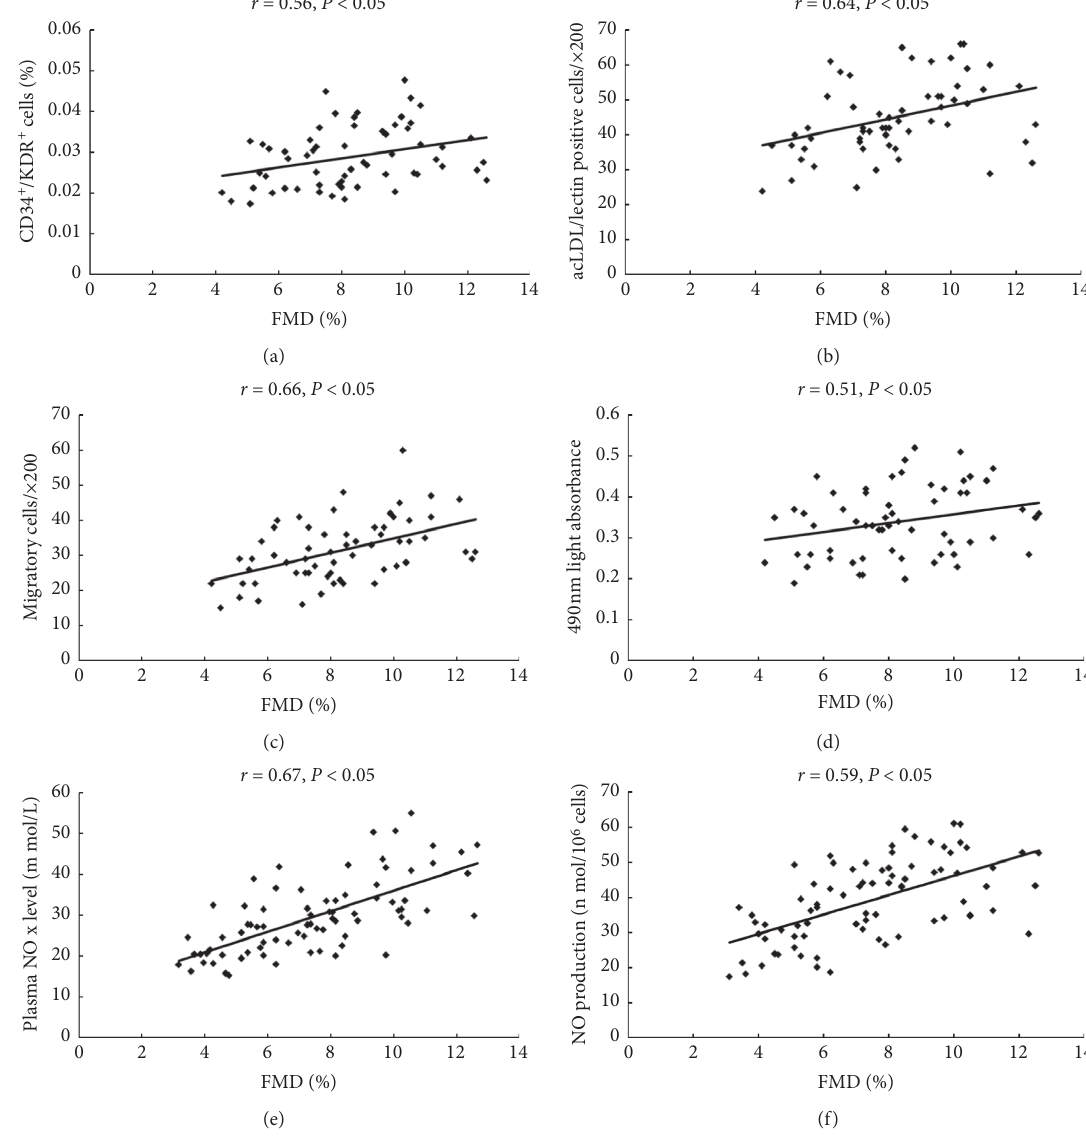
Figure 5: The correlation between circulating EPCs or NO level and FMD was shown as follows. The number of circulating EPCs evaluated by FACS (a) or by cell culture (b) correlated with the FMD. There was a correlation between the EPC proliferation (c) or migratory (d) and FMD. In addition, there was a correlation between the plasma NO level (e) or NO secretion by EPCs (f) and